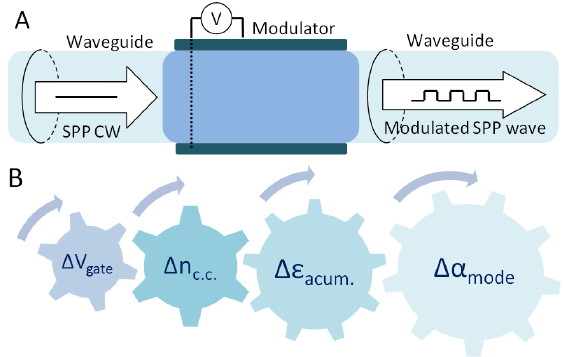
Figure 4: (A) General concept of a plasmonic modulator